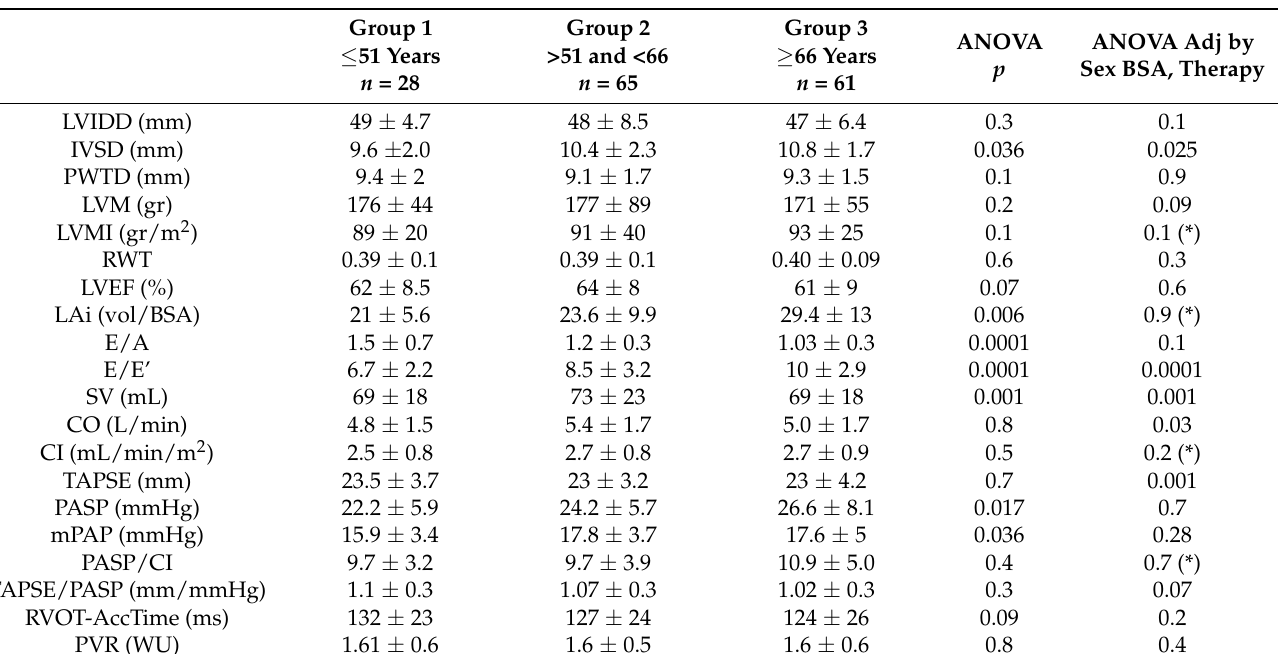
Table 5. Baseline echocardiographic characteristics in hypertensive patients divided into 3 groups of